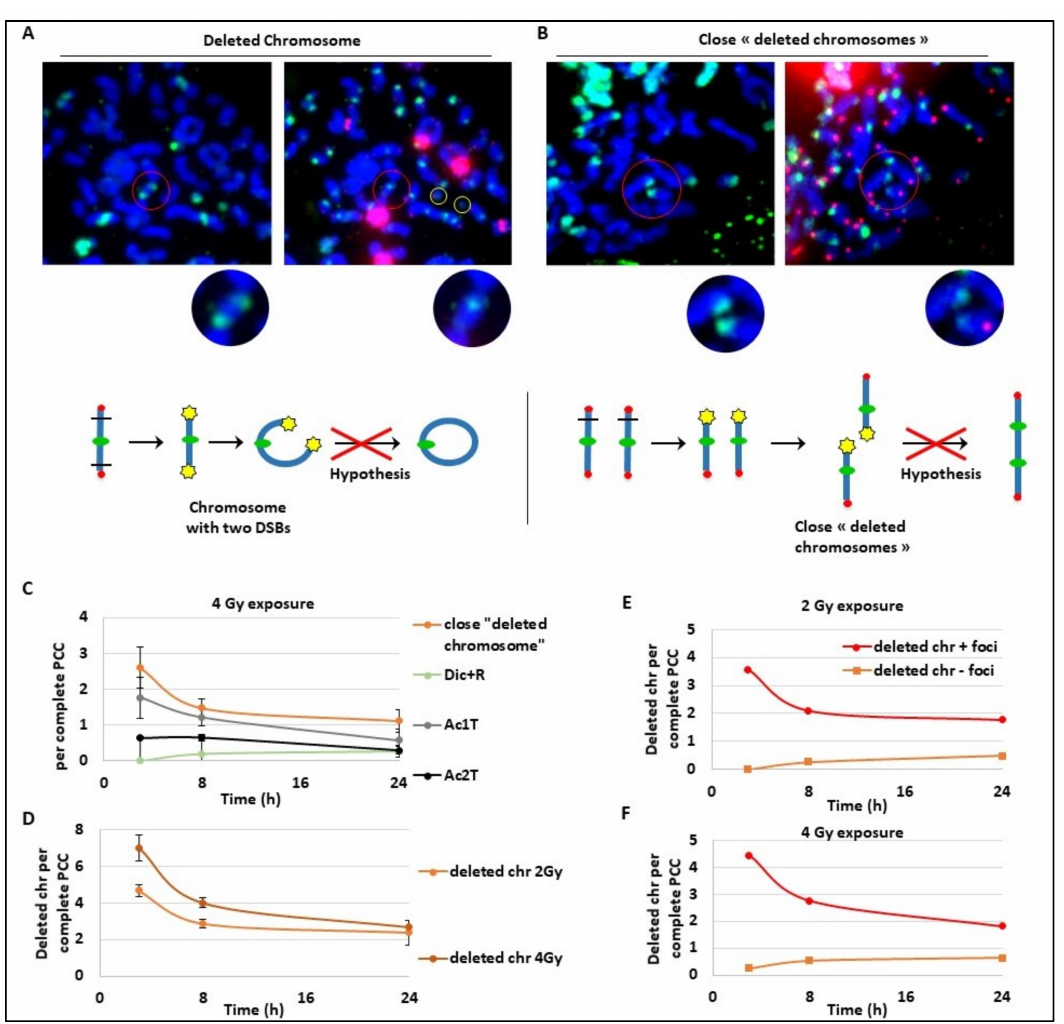
Figure 4. Kinetics of late and slow DNA repair mechanisms. Blood samples from three donors were irradiated at 2 or 4 Gy or kept free from ionising radiation, analysed using the PCC technique and fixed 3 h, 8 h, or 24 h post-exposition. ( A , B ) Images of the same PCC exposed to 4Gy were observed after γ -H2AX immunofluorescence staining (in green on the left panels) and after TC staining (right panels). Centromeres are stained in green and telomeres in red after PNA-FISH staining. Red circles show the zones of interest and yellow circles indicate acentric fragments. A chromosome with two DSBs ( A ) and two chromosomes with close signalled DSBs ( B ) are both signalled by γ -H2AX and considered as “in repair”. In ( A ), the chromosome is expected to become a ring while in ( B ), the two chromosomes are expected to fuse and make a dicentric chromosome. Below each image, a schema represents the hypothetical mechanism of CA formation. On the schema, centromeres are represented with green circles, telomeres with red circles, and γ -H2AX foci with yellow stars. The red crosses on the hypothesis conclude that the data will not confirm the hypothesis. ( C – F ) Scoring was performed only on complete PCC cells containing between 45 and 48 fragments. ( C ) The frequency of “close deleted chromosomes”, Dic + R, Ac1T, and Ac2T, per PCC were reported at 3 h, 8 h, and 24 h after 4 Gy irradiation. ( D ) The frequency of deleted chromosomes (with one telomere only) was followed after 2 and 4 Gy irradiation at three time points: 3 h, 8 h, and 24 h post-IR. ( E , F ). The proportion of deleted chromosomes containing γ -H2AX signalling or not signalled was quantified after 2 Gy ( E ) and 4 Gy ( F )